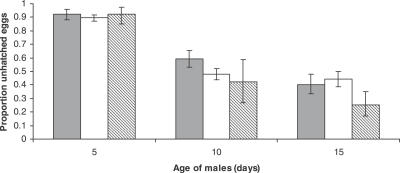
Levels of CI Induced by Wolbachia-Infected D. simulans Males 5, 10, and 15 d Post-Eclosion When Mated to Uninfected FemalesIsofemale lines originated from California in 1988 (hatched bars), 1999 (grey bars), and 2002 (white bars). Error bars are 95% confidence intervals.